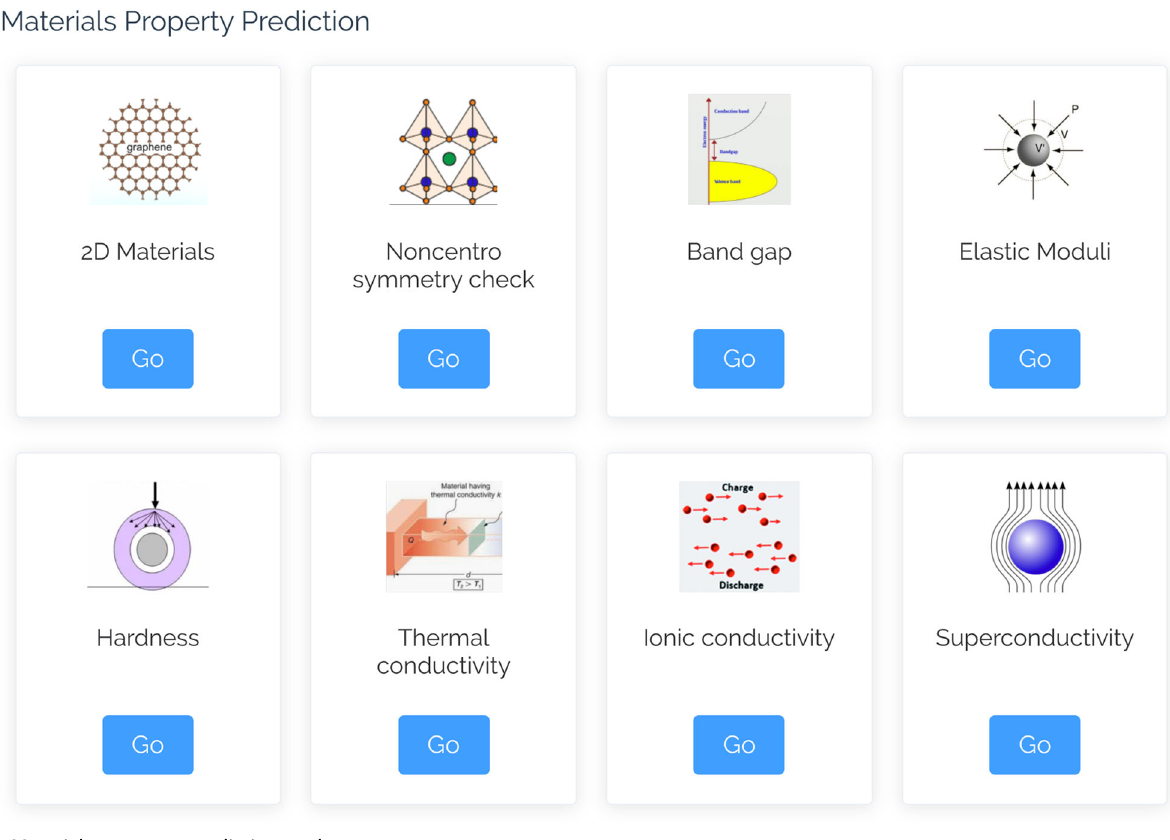
Fig. 2 Materials property prediction